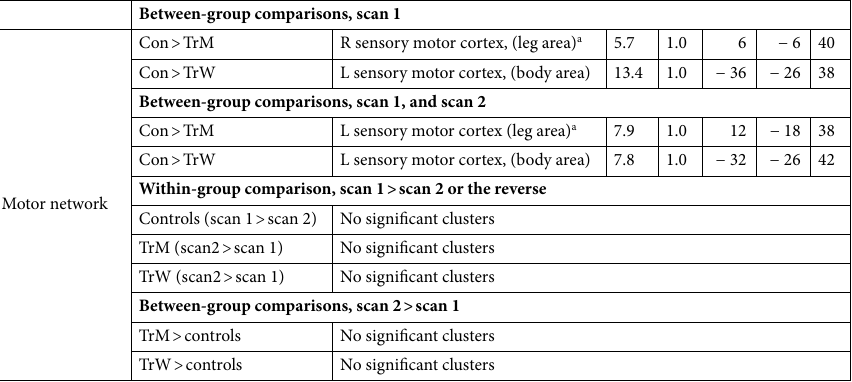
Table 5. Connectivity in motor network before (scan 1) and after (scan 2) cross-sex hormone treatment in TR persons, (controls were not treated). mPFC, mesial prefrontal cortex; lPFC, lateral prefrontal cortex; ACC, anterior cingulate cortex. Calculations at 1 − p > 0.98, cluster size > 1.0 cc. a Covers both right and left